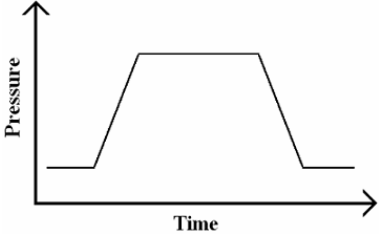
Fig. 18. Pressure change in test